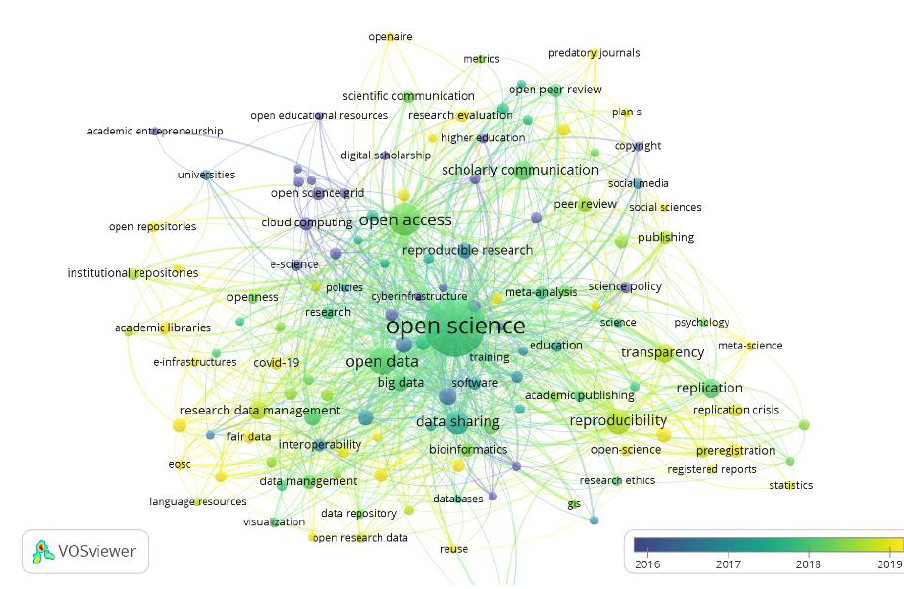
Figure 5. Visualization of the Evolution of Relationships Between Categories Source: Compiled by the authors using VOSViewer (VOSViewer,